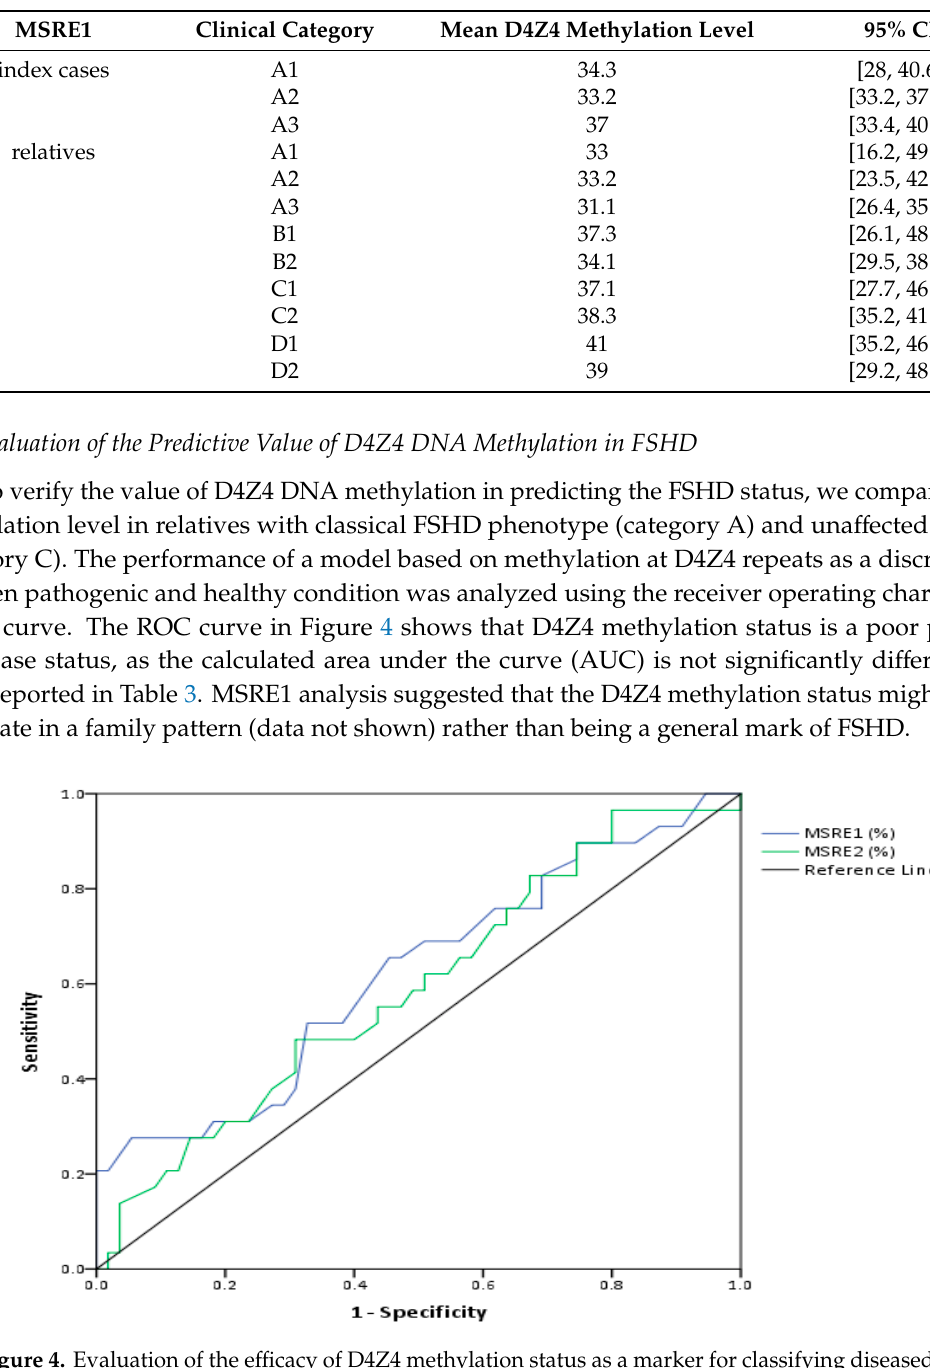
Table 2. The mean D4Z4 methylation values for the MRSE1 assay graphed in Figure 3A and the 95% confidence interval (CI).